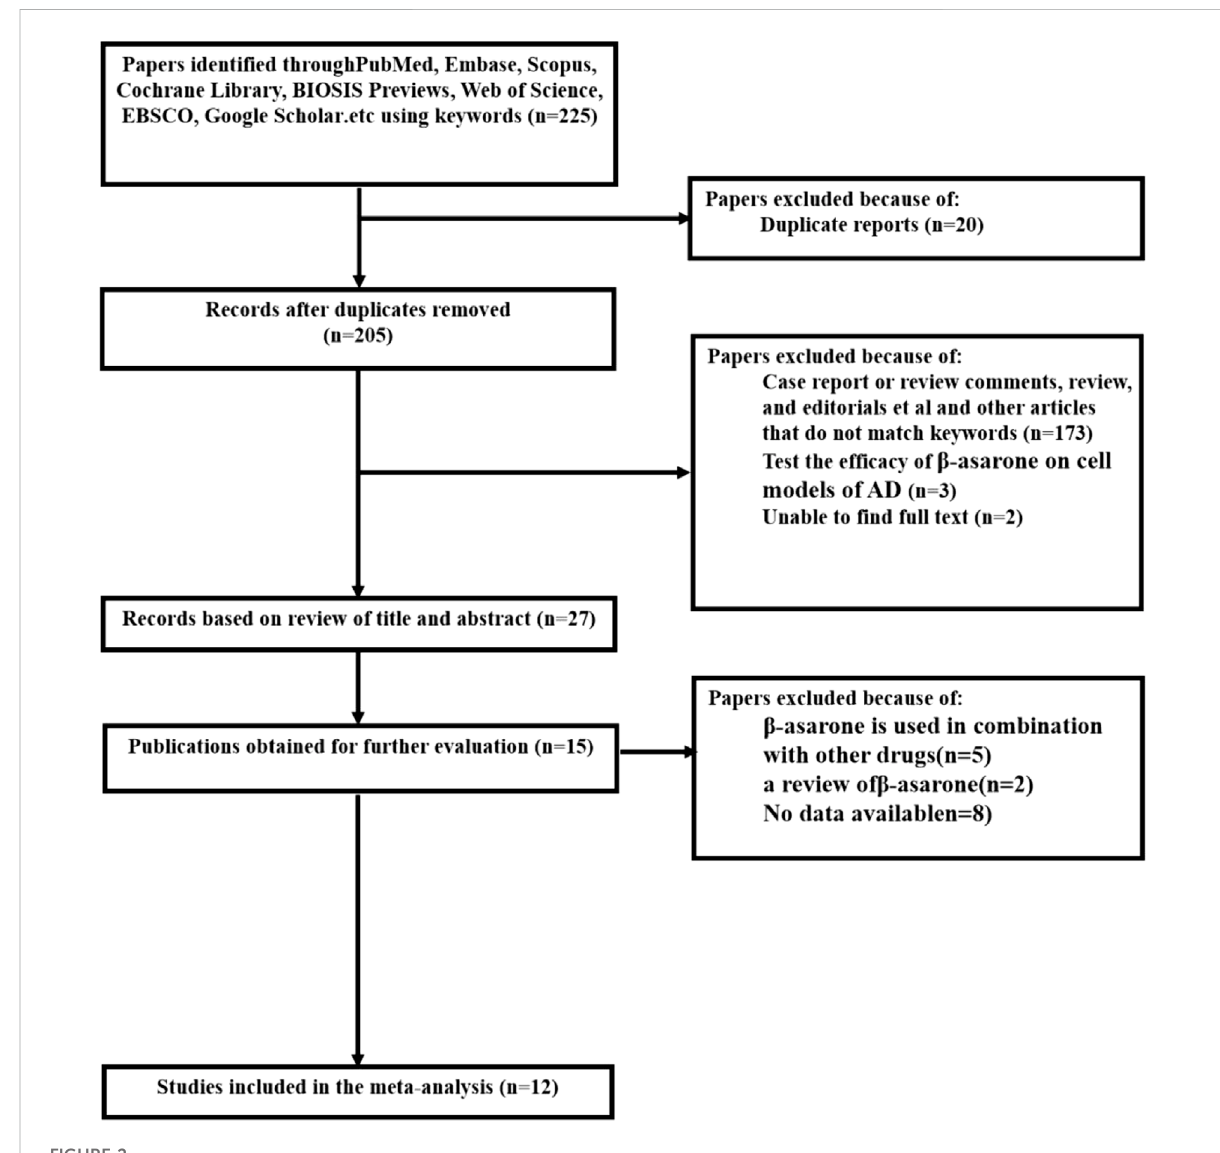
FIGURE 2 Literature search